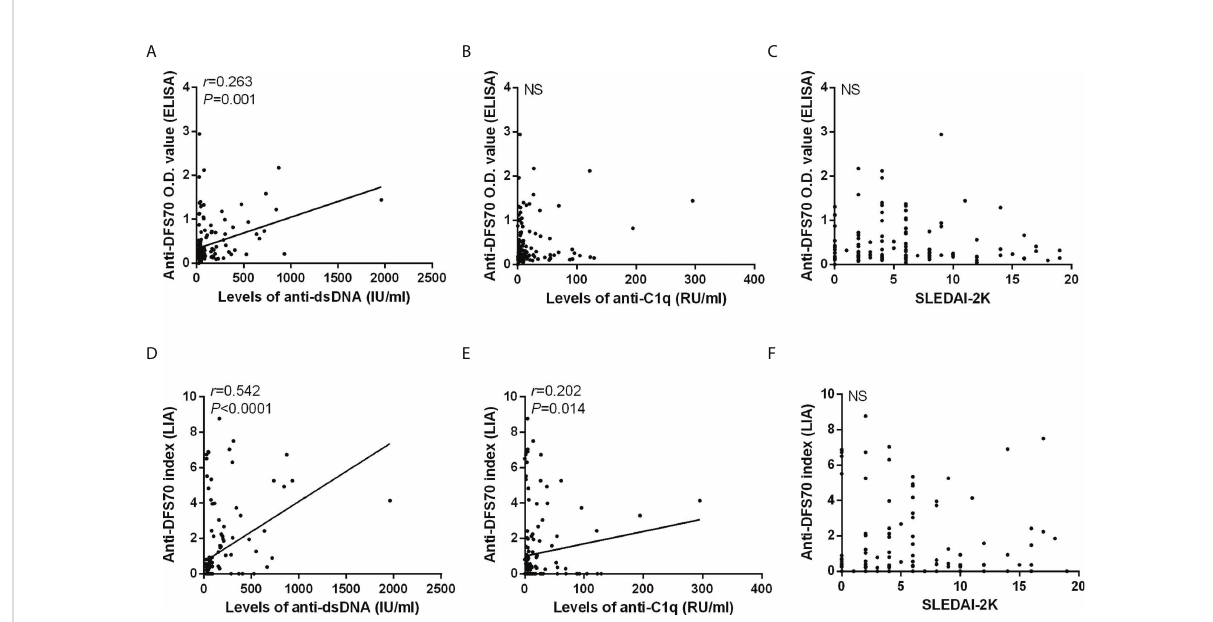
FIGURE 3 Correlations of anti-DFS70 with markers of disease activity in 149 sera from 61 follow-up SLE patients. Correlations of anti-DFS70 O.D. value by ELISA with the levels of anti-dsDNA antibodies (A) , anti-C1q antibodies (B) , and SLEDAI-2K (C) . Correlations of the anti-DFS70 index by LIA with the levels of anti-dsDNA antibodies (D) , anti-C1q antibodies (E) , and SLEDAI-2K (F) . DFS70, dense fi ne speckles 70; ELISA, enzyme-linked immunosorbent assay; LIA, line immunoassay; NS, no signi fi cance; O.D. value, optical density value; r , correlation coef fi cient; SLEDAI-2K, Systemic Lupus Erythematosus Disease Activity Index